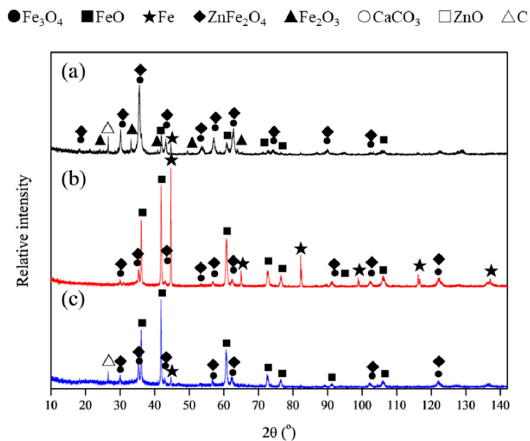
Figure 7. The XRD patterns of the corresponding leaching residues. ( a ) Residue of BOS-1; ( b ) Residue of BOS-2; ( c ) Residue of BOS-3. Metals 2019 , 9 , x FOR PEER REVIEW